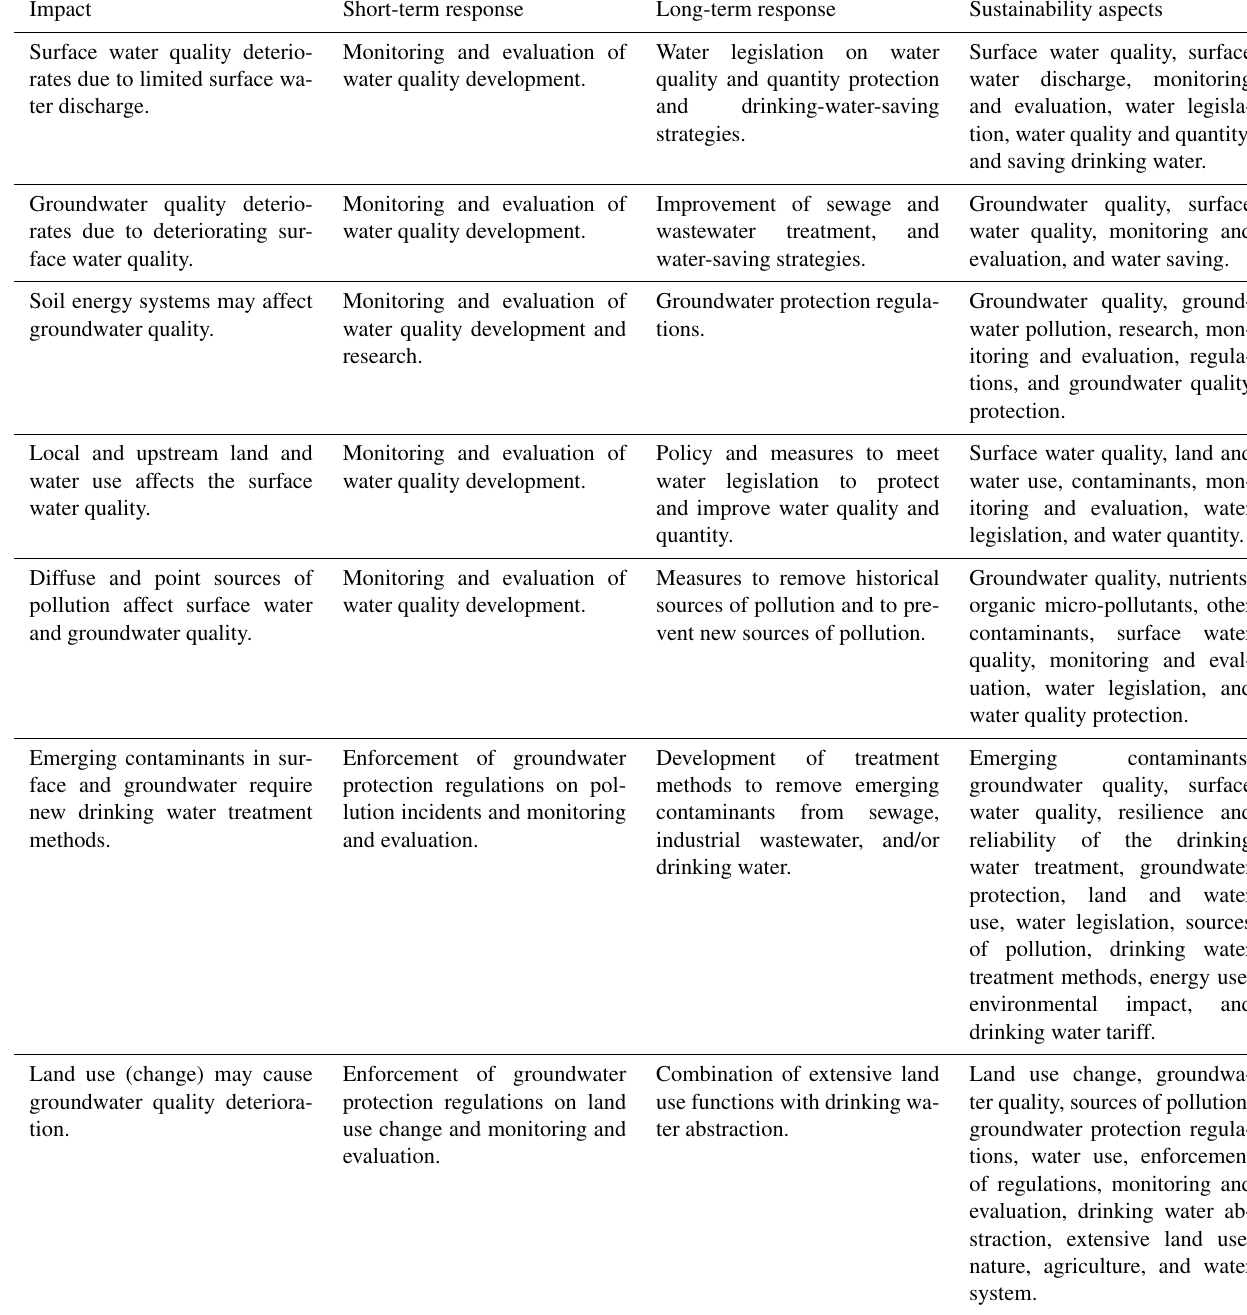
Table B1. Summary of the impact, short- and long-term response, and sustainability aspects in case 2 – groundwater quality development (for complete results of the case study, see Table